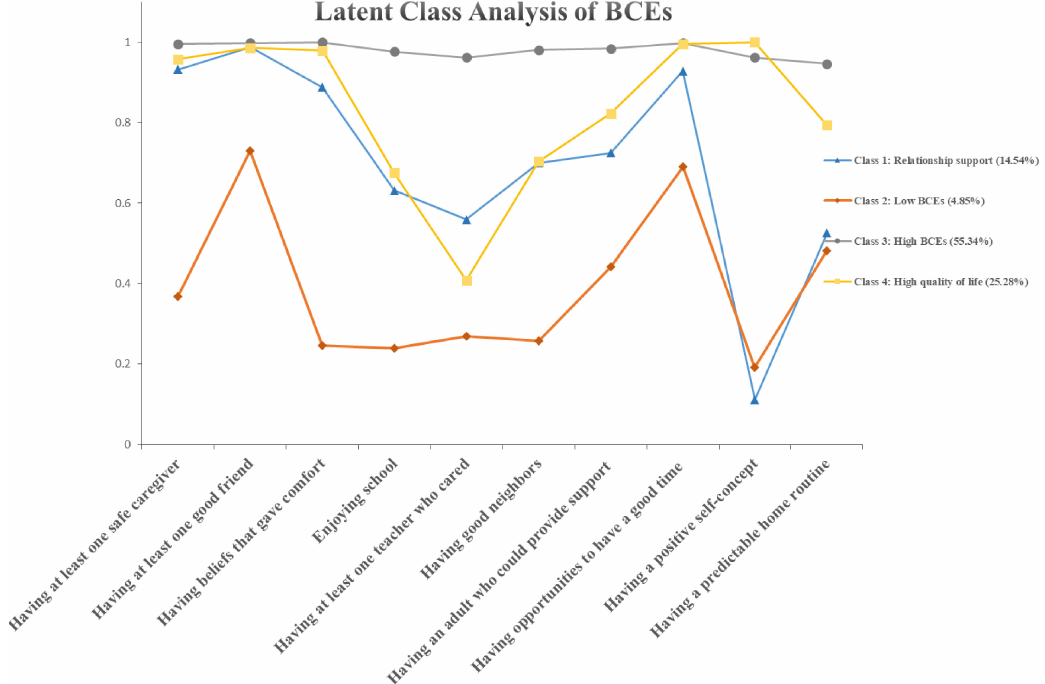
Fig. 2 Probabilities of BCEs items by childhood experiences pattern derived by LCA Note: BCEs = benevolent childhood experience; LCA = latent class analysis